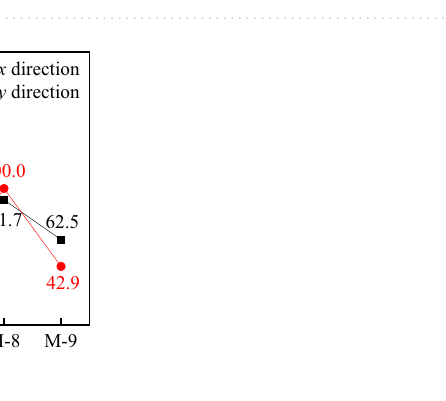
Figure 16. Growth rate of model displacement with seismic intensity for each bridge